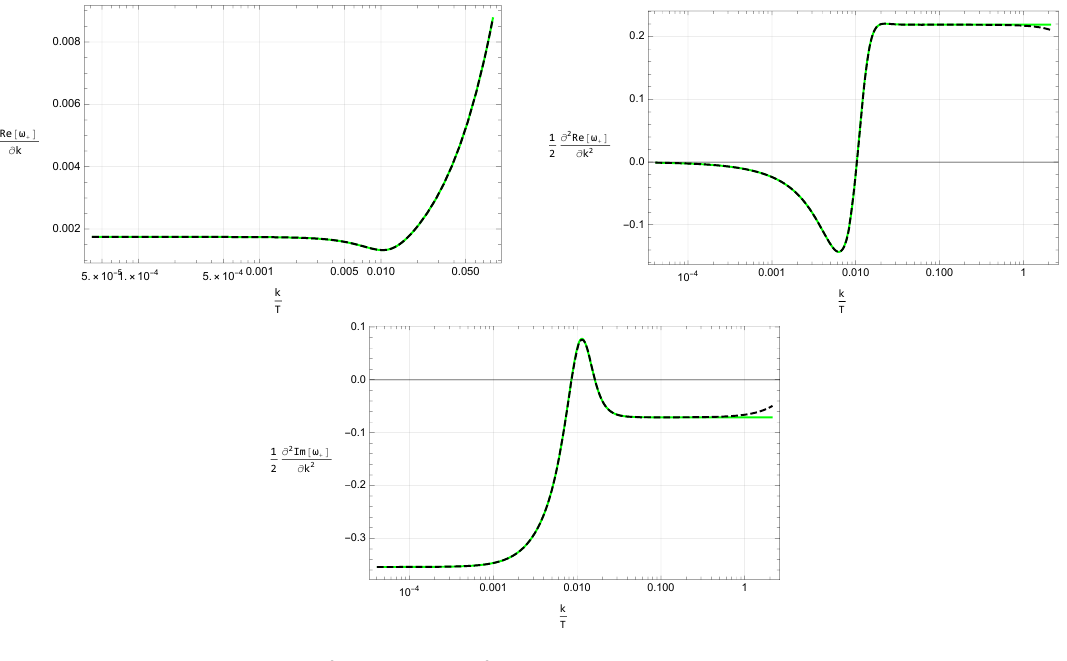
∂ 2 Re ω + ∂ 2 Im ω + , 1 and 1 for the Goldstone mode as a function of k for ∂k 2 ∂k 2 2 ∂k 2